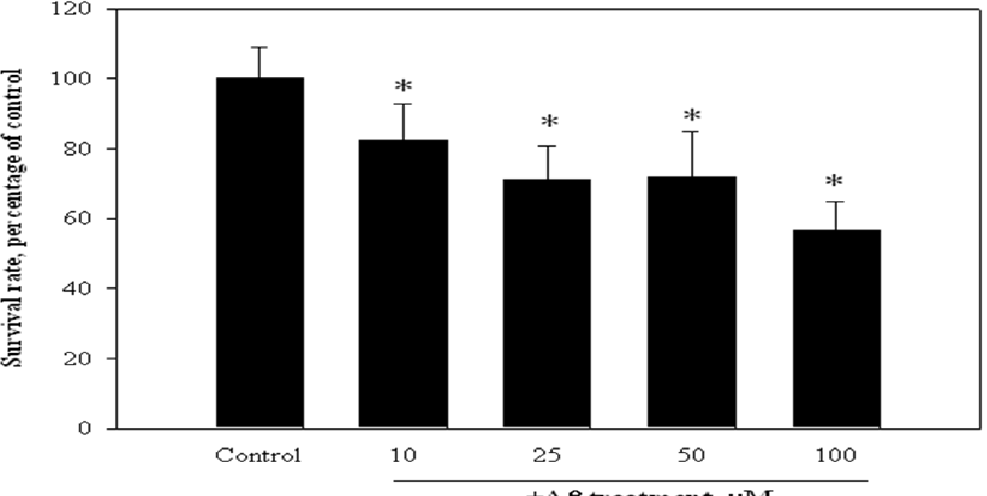
peptide on the survival of microglial cells. (25-35)